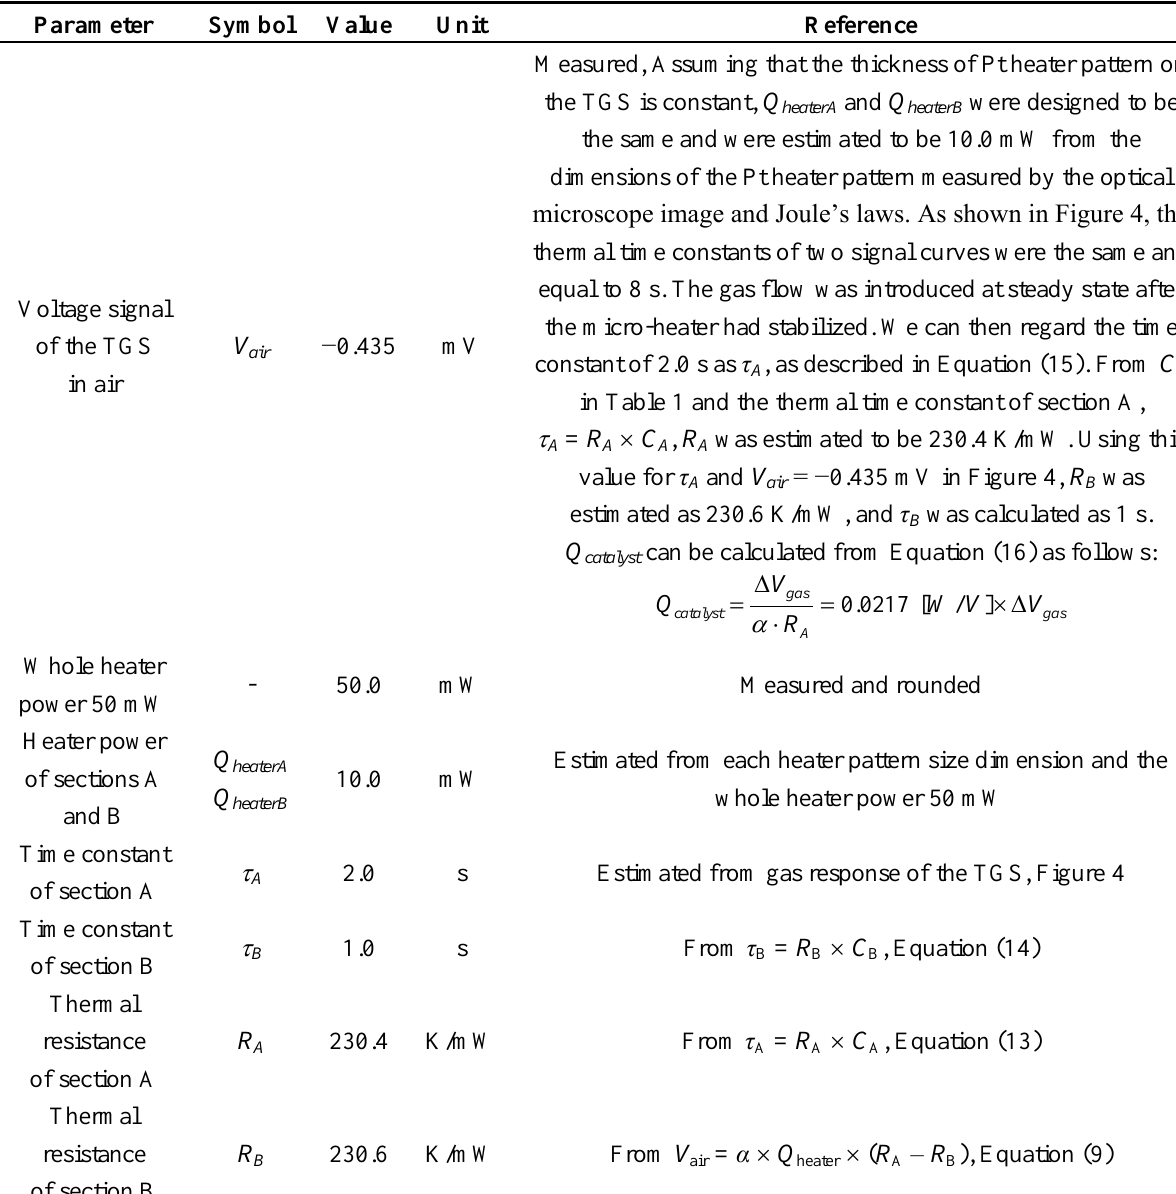
Table 2. Estimated parameters from the experimental response curve of the TGS for 200 ppm and 1,000 ppm hydrogen (Figure 4). The catalyst of the TGS device was heated up to 120 °C by its